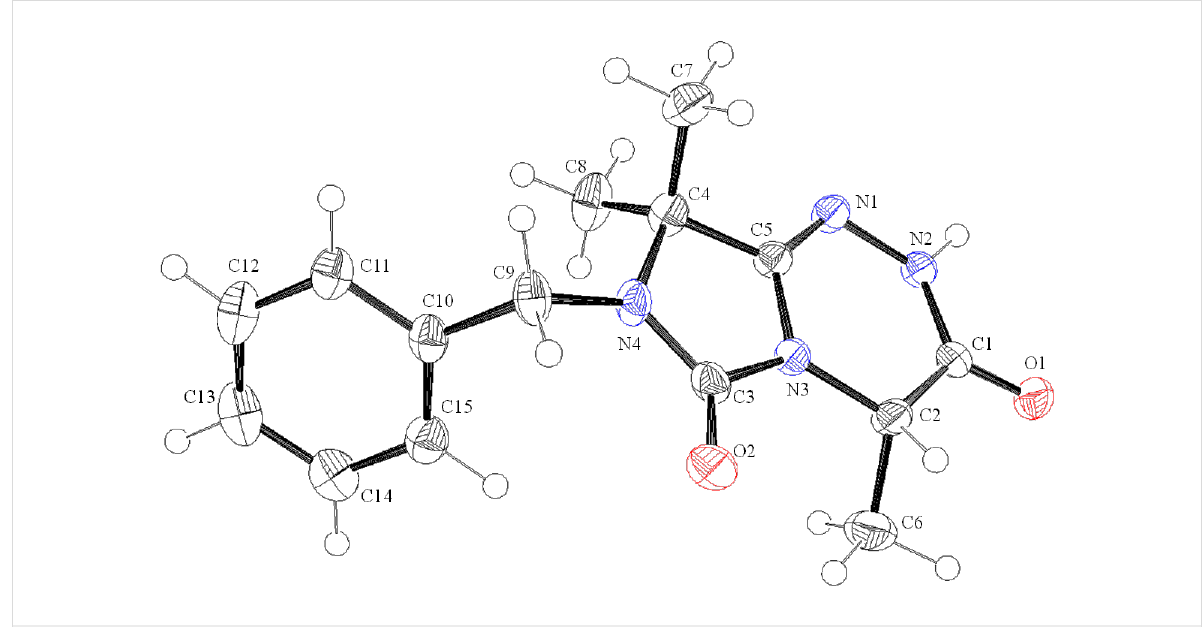
Figure 3: ORTEP diagram of 24 showing the atomic numbering. The thermal ellipsoids are drawn at the 50% probability level.